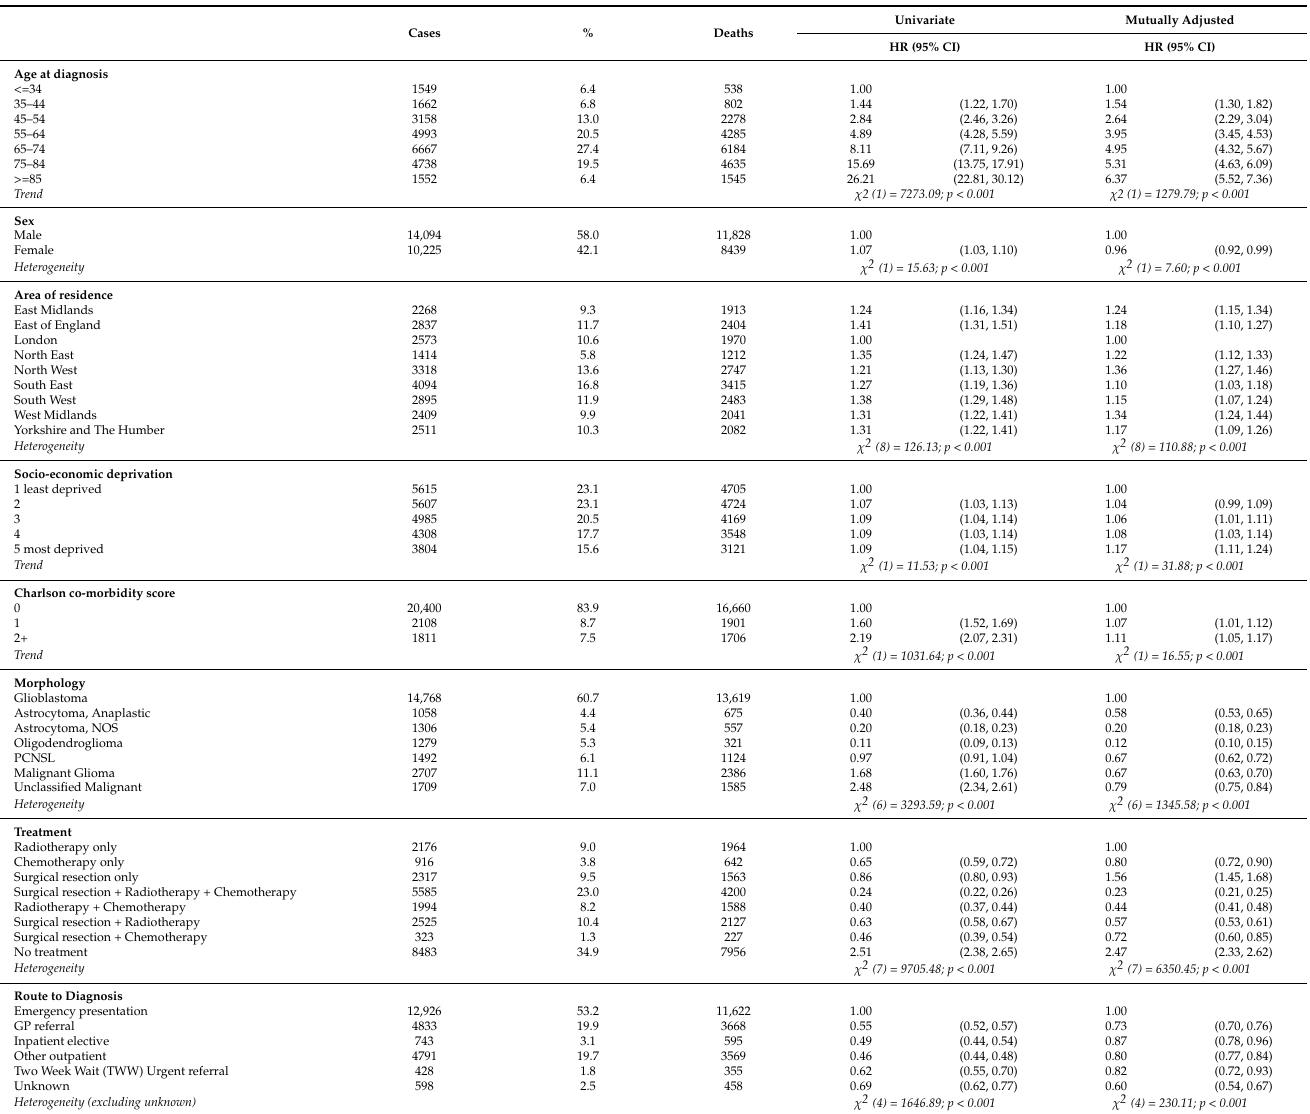
Table 1. Distribution of covariates in survival analysis of malignant primary brain tumours patients diagnosed in England, 2012–2017 with follow-up to 2018. Univariate and mutually adjusted Cox proportional hazards regression analyses to estimate hazard